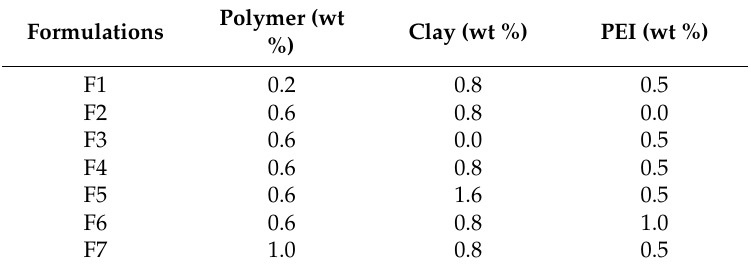
Table 5. Gelling system formulations prepared with PAM–AMPS–NVP terpolymer, polycationic bentonite, and PEI with 70,000 kg/kmol and pH value of 11 in injection water or field